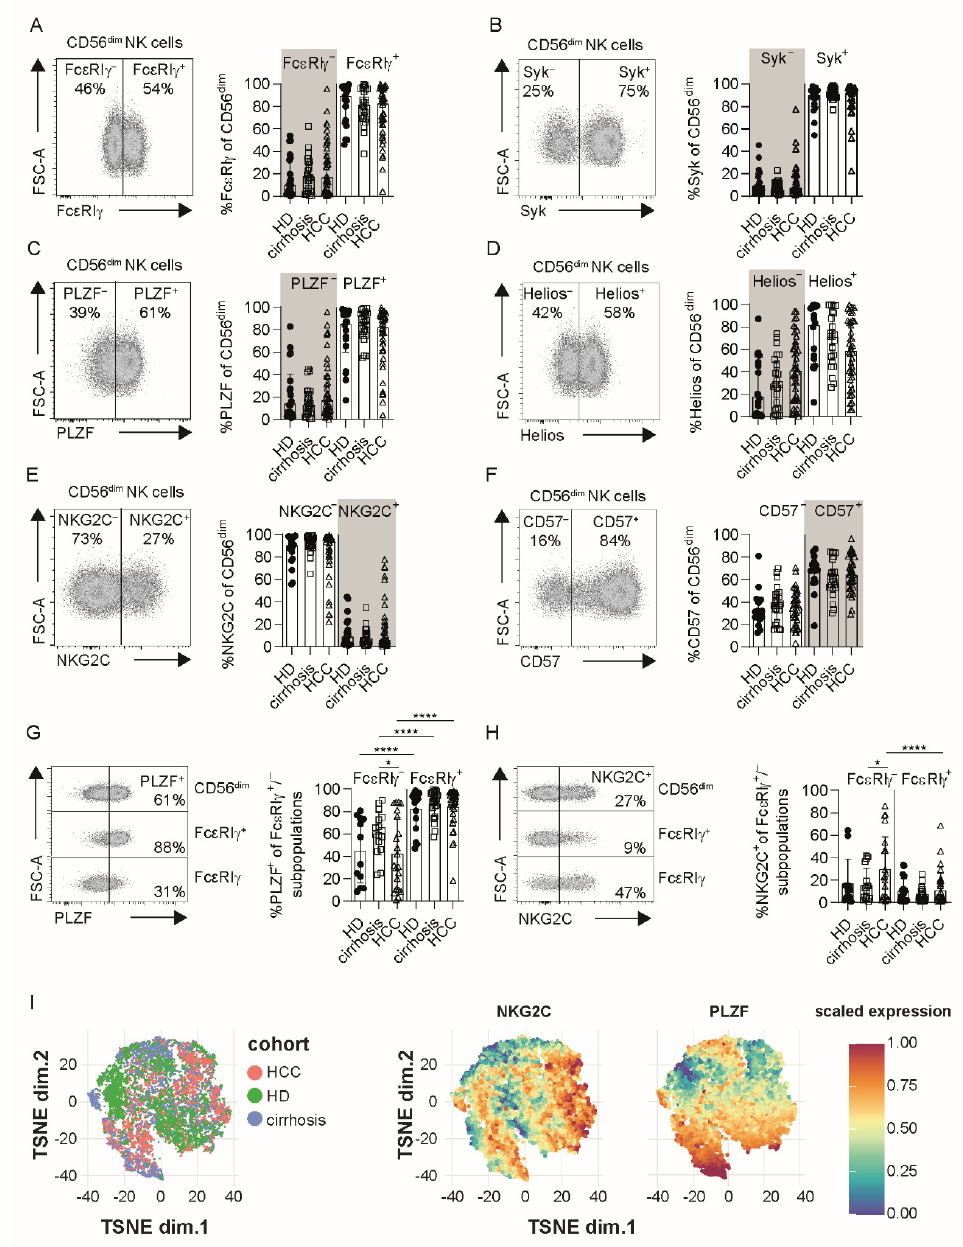
Figure 1. Adaptive NK-cell signatures are conserved in HCC patients. Fc ε RI γ ( A ), Syk ( B ), PLZF ( C ), Helios ( D ), NKG2C ( E ) and CD57 ( F ) expression on CD56 dim NK cells in HCMV + HCC patients ( n = 42 in ( A , D ) n = 28 in ( B ), n = 40 in ( C ), n = 39 in ( E ), n = 37 in ( F )), HD ( n = 21 in ( A ), n = 16 in ( B , D , F ), n = 18 in ( C , E )) and patients with liver cirrhosis ( n = 24 in ( A , C – F ), n = 18 in ( B )). PLZF ( G ) and NKG2C ( H ) expression of Fc ε RI γ − and Fc ε RI γ + subpopulations in HCC patients (Fc ε RI γ − n = 21, Fc ε RI γ + n = 34), HD (Fc ε RI γ − n = 12, Fc ε RI γ + n = 21) and patients with liver cirrhosis (Fc ε RI γ − n = 16, Fc ε RI γ + n = 24). T-SNE analysis of concatenated flow cytometry data obtained from Fc ε RI γ − CD56 dim NK cells in HCC patients, HD and patients with liver cirrhosis (right). Expression levels of NKG2C and PLZF are plotted on the t-SNE plots (left) ( I , HCC n = 32, cirrhosis n = 19, HD n = 17). Cells in the grey box correspond to the phenotype of adaptive NK cells ( A – F ). Each dot represents an HCMV + individual. Bars indicate median with IQR. Statistical significance for cohort comparison